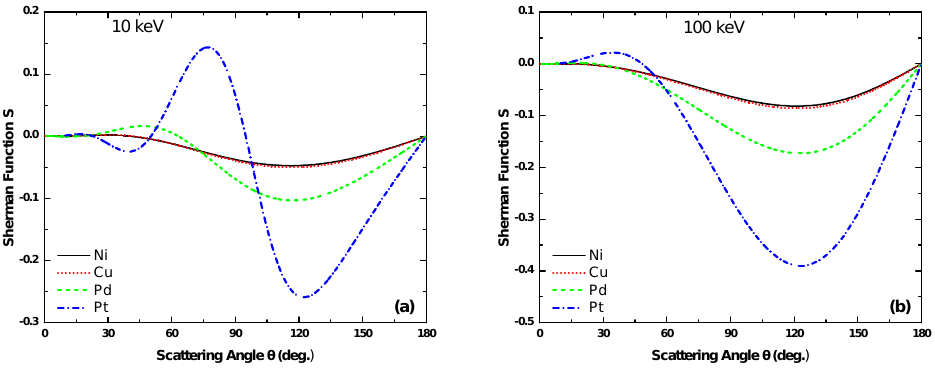
Figure 13. Angular variation of the Sherman function due to the present OPM approach for electron scattering from Ni 58 , Cu 63 , Pd 108 , and Pt 196 at impact energies of 10 keV ( a ) and 100 keV ( b ).